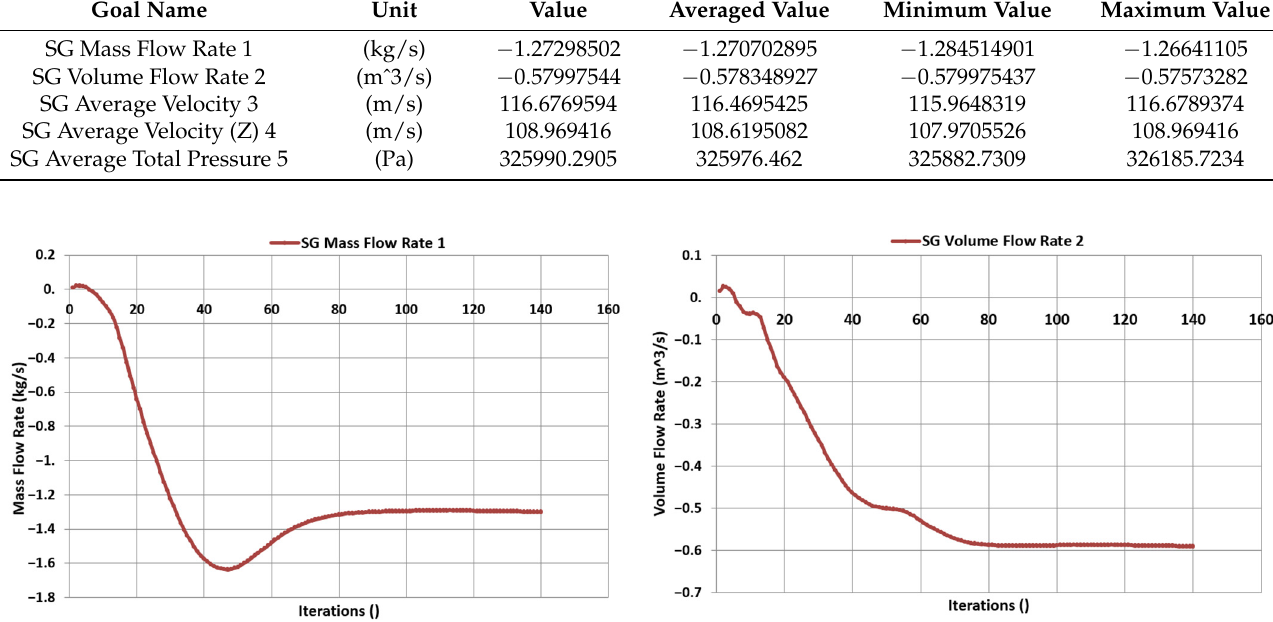
Figure 14. Mass and Volume Flow Rate of turbine intake for Figure 8.